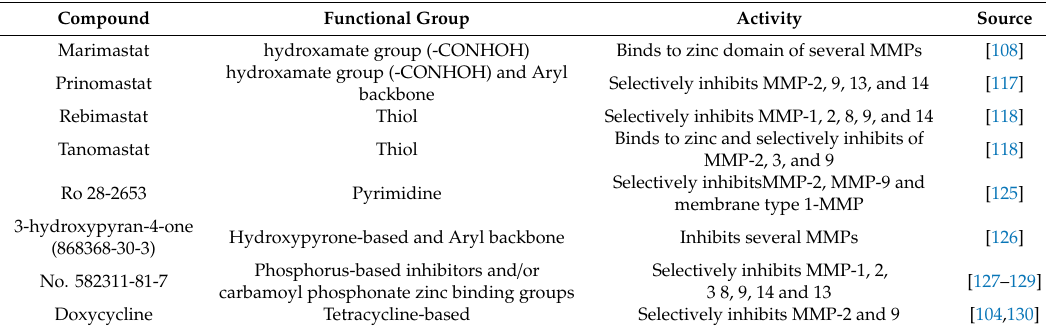
Table 2. Structure of synthetic MMPi